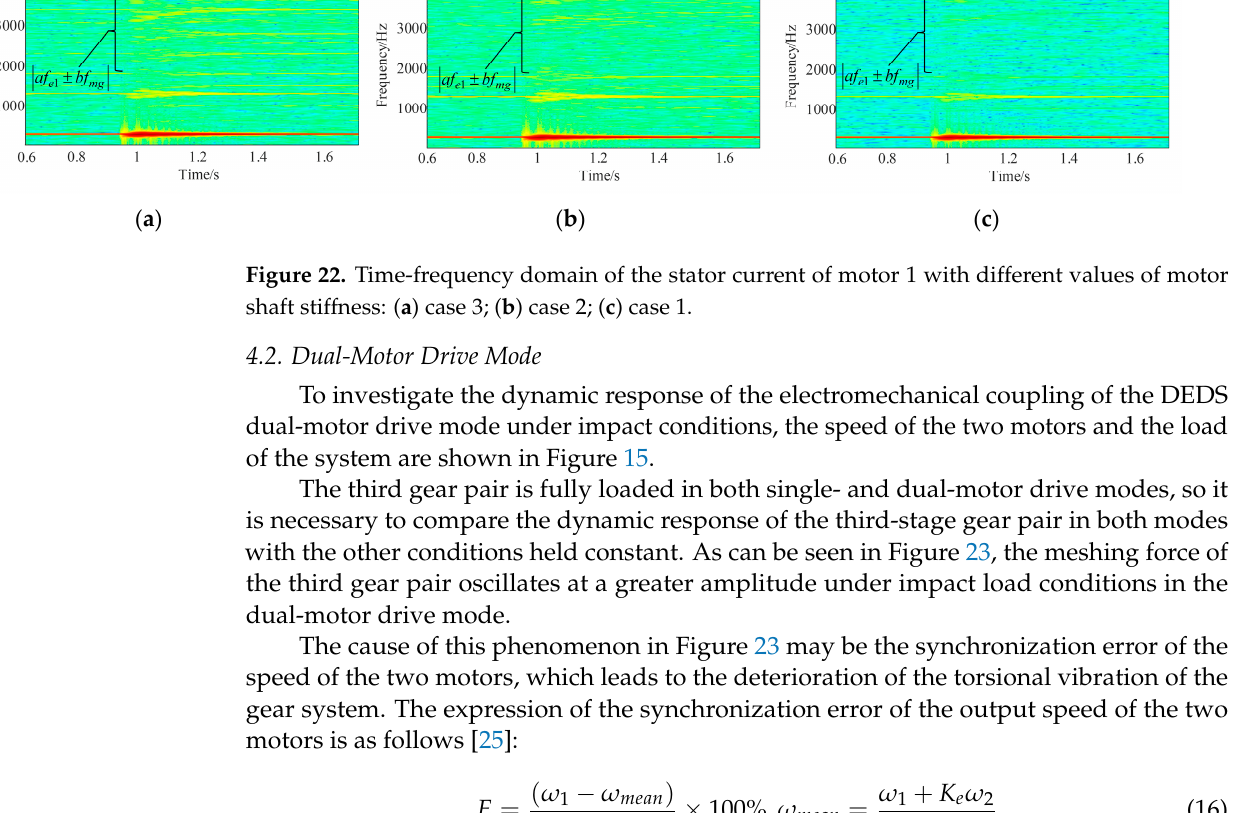
Figure 22. Time-frequency domain of the stator current of motor 1 with different values of motor shaft stiffness: ( a ) case 3; ( b ) case 2; ( c ) case 1.